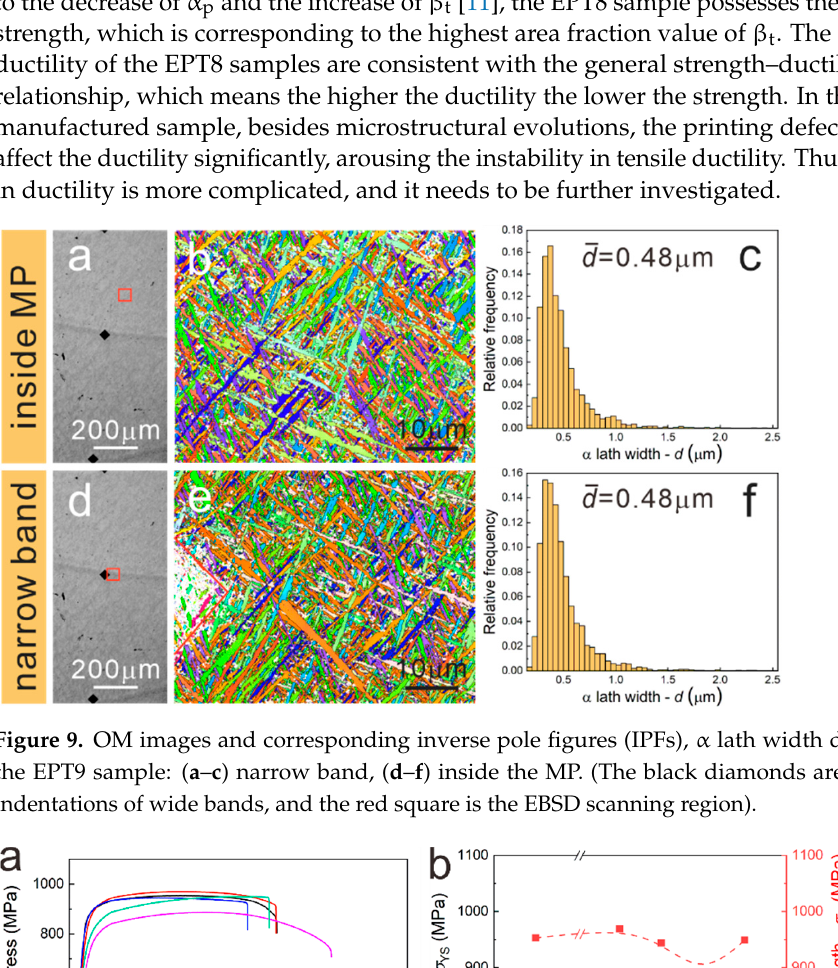
Figure 9. OM images and corresponding inverse pole figures (IPFs), α lath width distribution of the EPT9 sample: ( a – c ) narrow band, ( d – f ) inside the MP. (The black diamonds are the marking indentations of wide bands, and the red square is the EBSD scanning region).